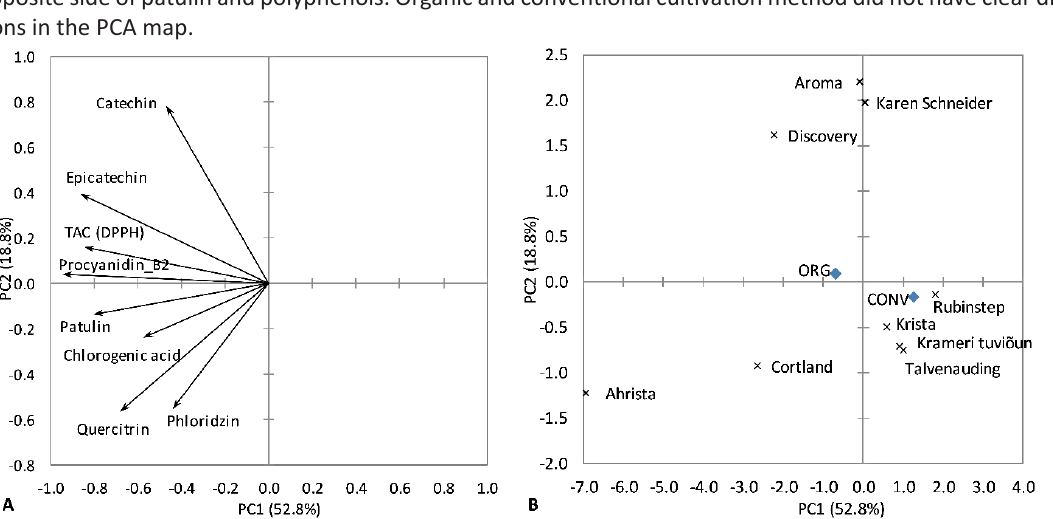
Fig. 3. Principal Component Analysis plots of the first two PC-s. The loading of patulin, antioxidant capacity and all analysed polyphenols are presented on the left (A) and the loading of cultivars and cultivation system on the right